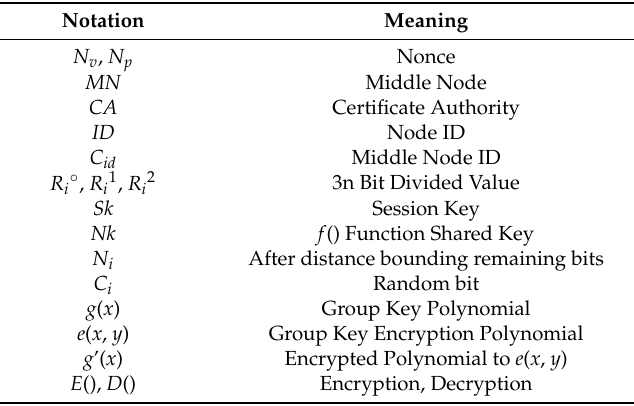
Table 1. Proposed protocol